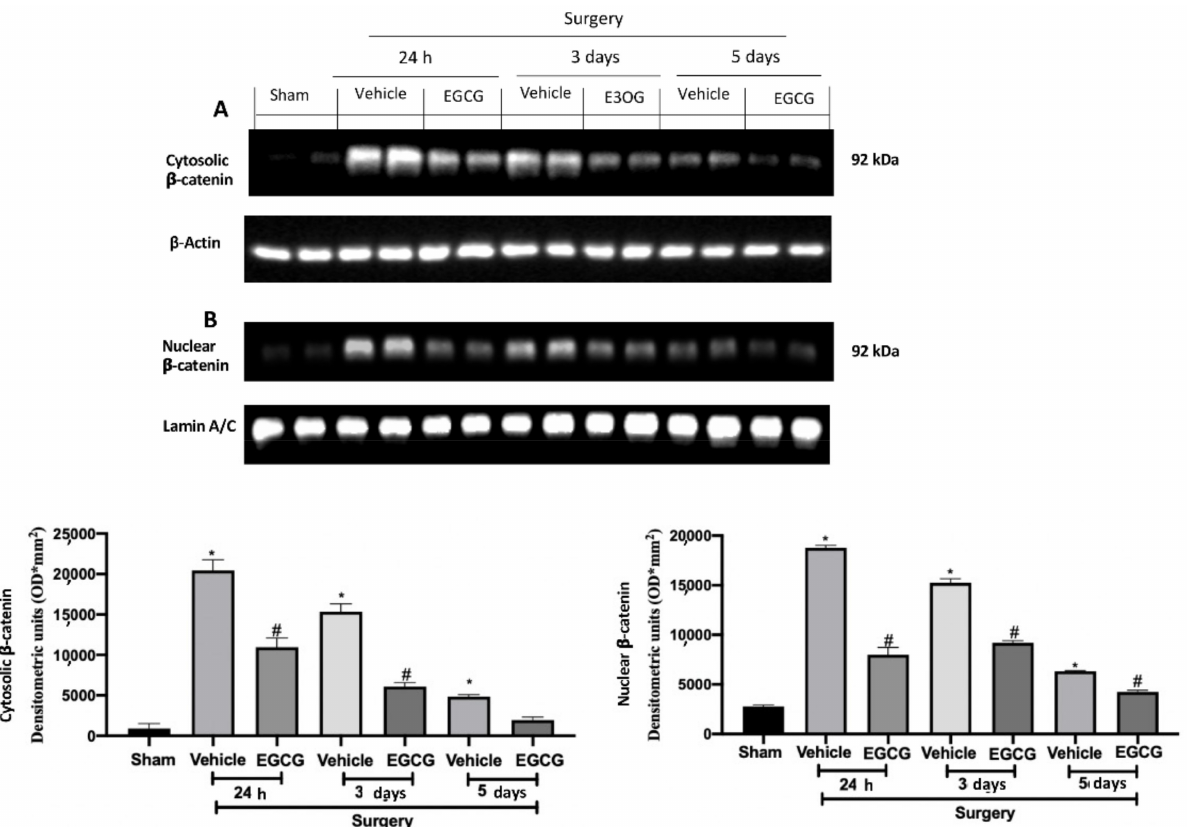
Figure 3. EGCG administration reduced β -catenin expression: Western blot analysis of: cytosolic β -catenin ( A ) and nuclear β -catenin ( B ) expression. A p -value of less than 0.05 was considered significant. * p < 0.05 vs. sham, # p < 0.05 vs.